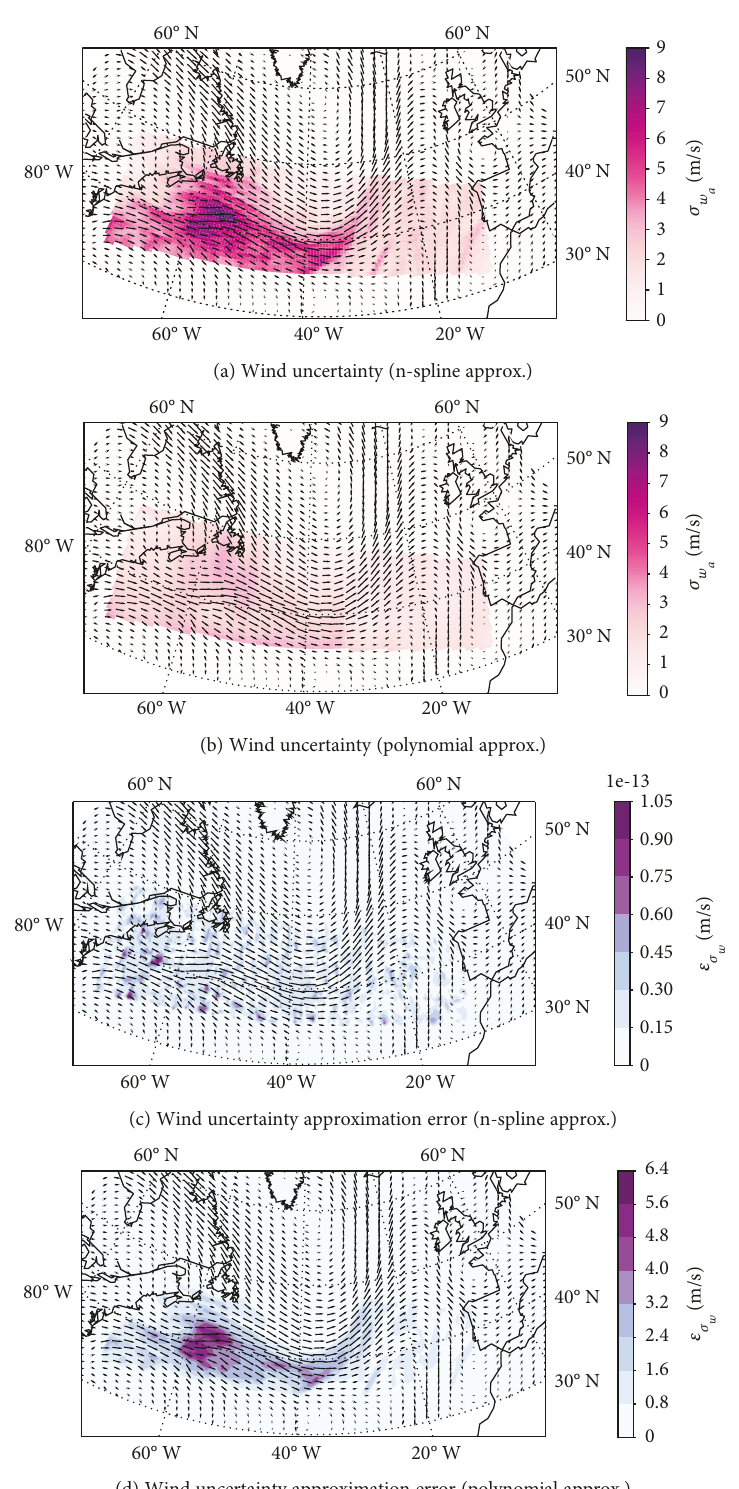
Figure 3: Wind approximations and associated errors (in